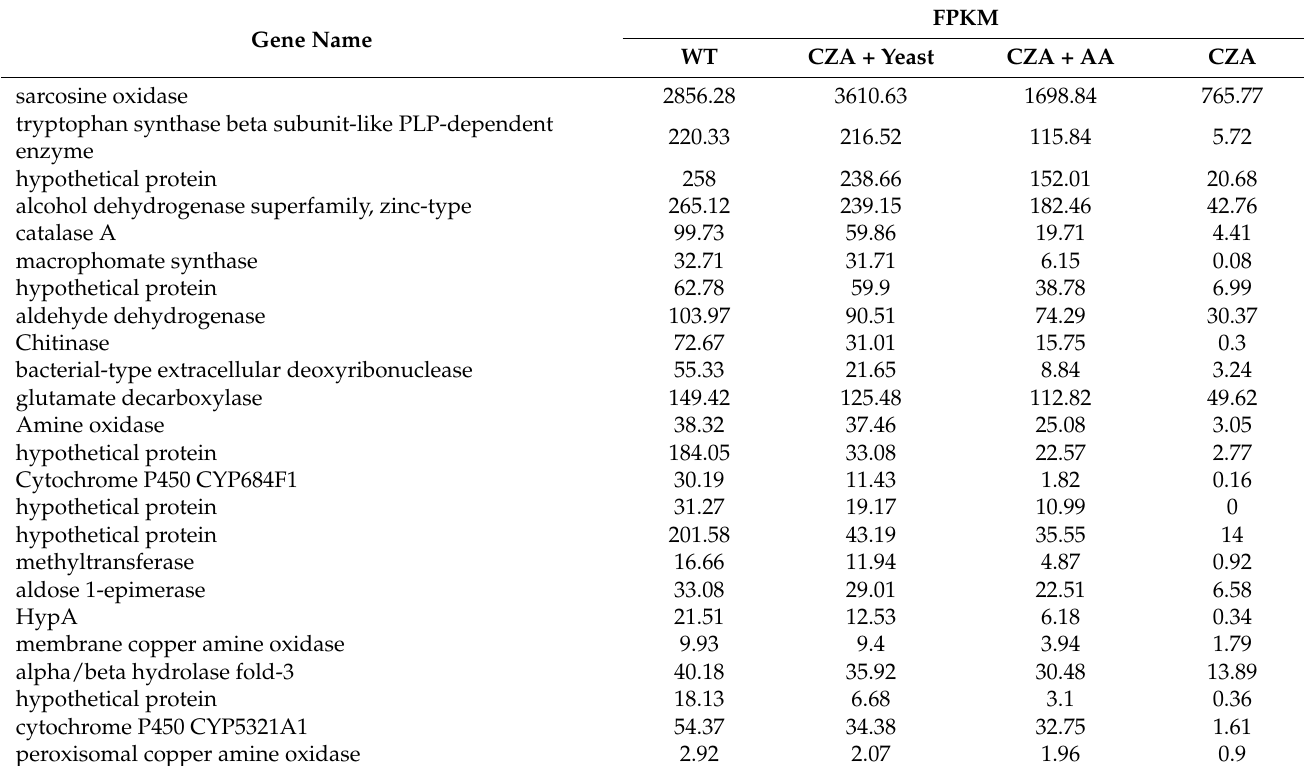
Table 3. Potential genes involved in mycelial